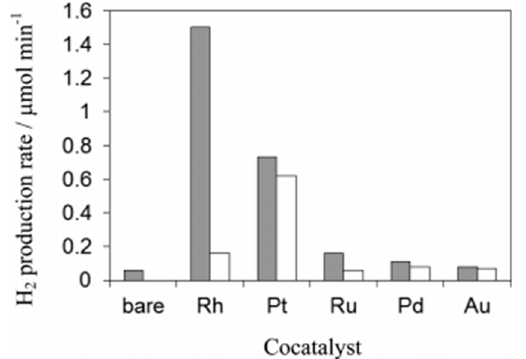
Figure 5. H 2 production rate for metal-loaded La-loaded K 2 Ti 6 O 13 under light irradiation. The loaded amount is 0.03%. The gray bar shows the H 2 production over various co-catalysts loaded using a photodeposition method and the white bar represents the impregnation method followed by calcination at 773 K. Reprinted with permission from [24]. Copyright (2010), American Chemical Society.